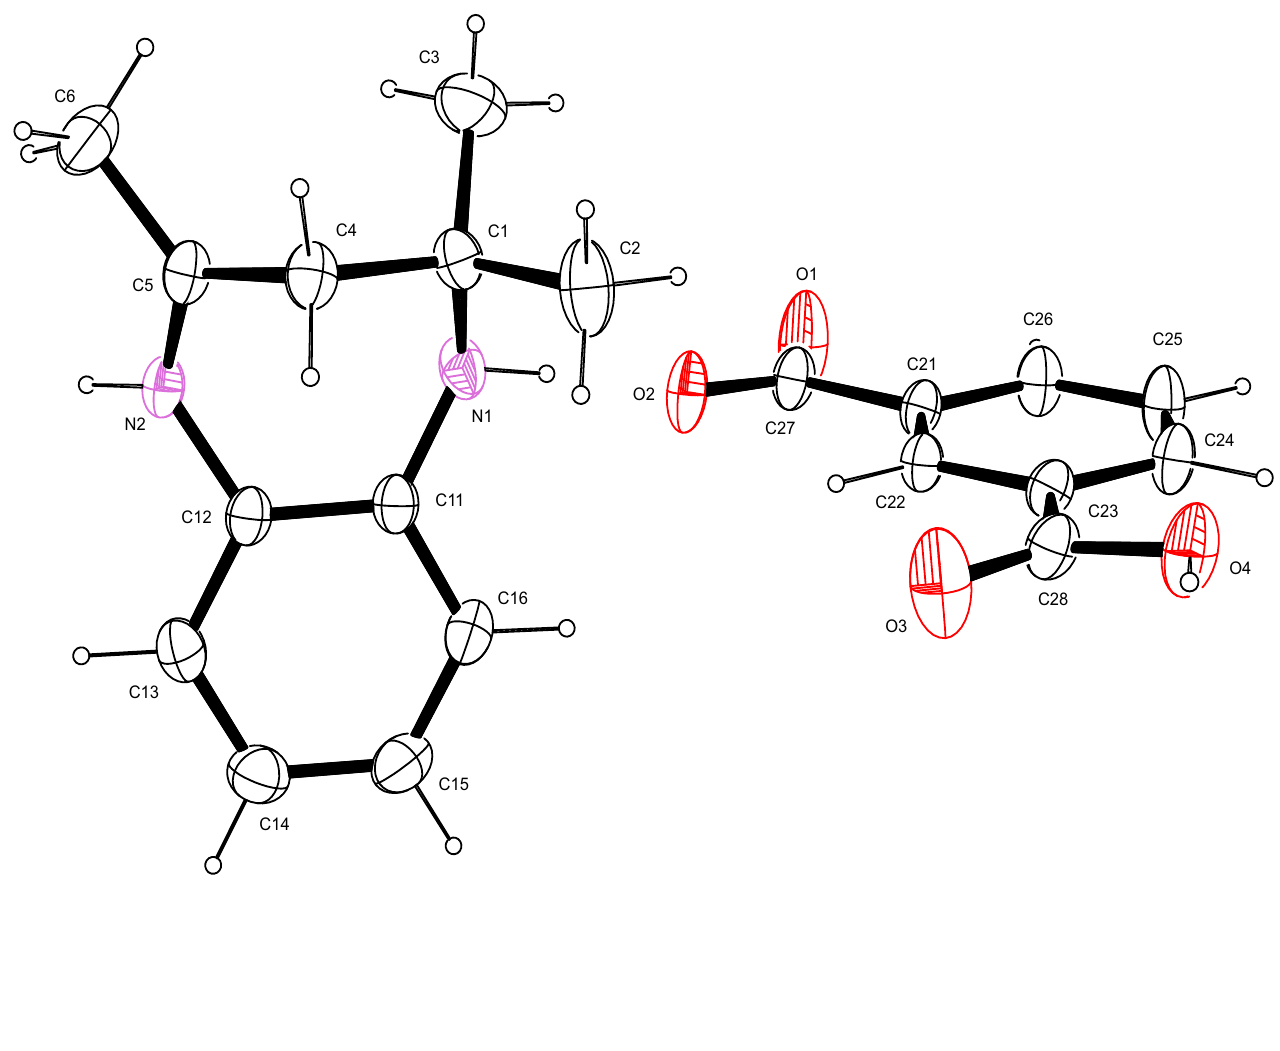
Figure 3. An ORTEP view of I showing 50% probability displacement ellipsoids and the atom